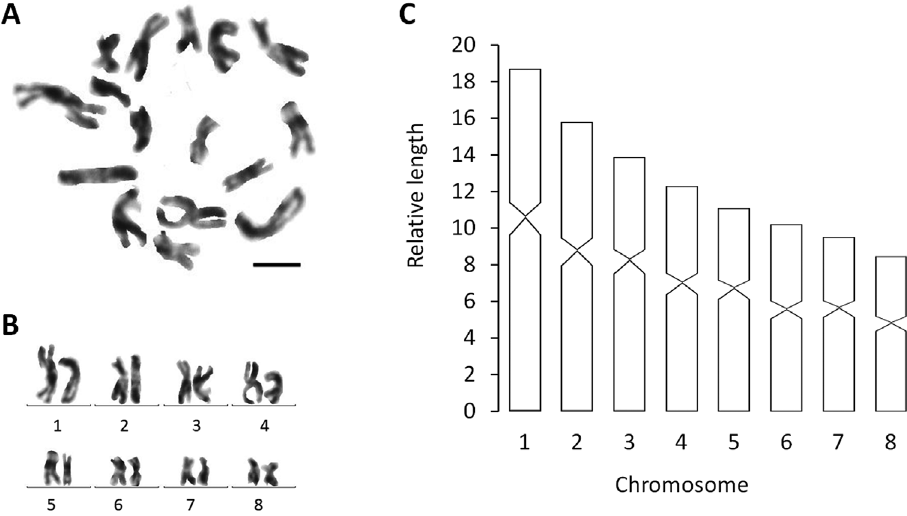
Figure 10. Dugesia verrucula A metaphasic plate, B karyogram C idiogram. Scale bar: 5